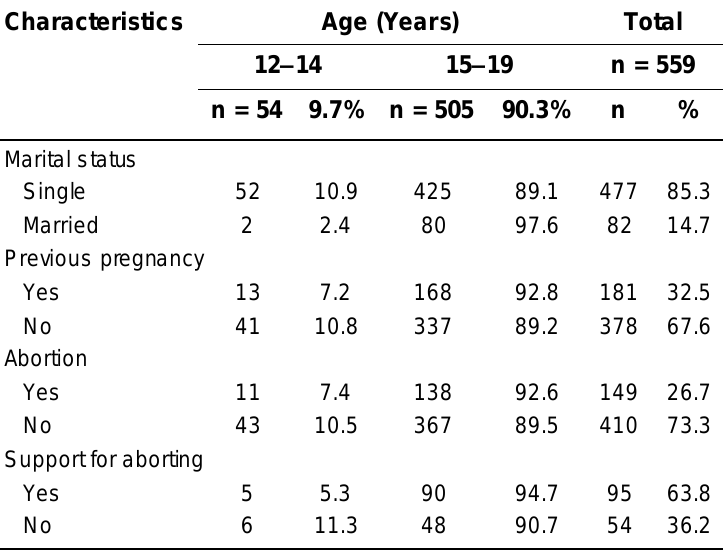
Characterization of Adolescents with Sexually Active Life